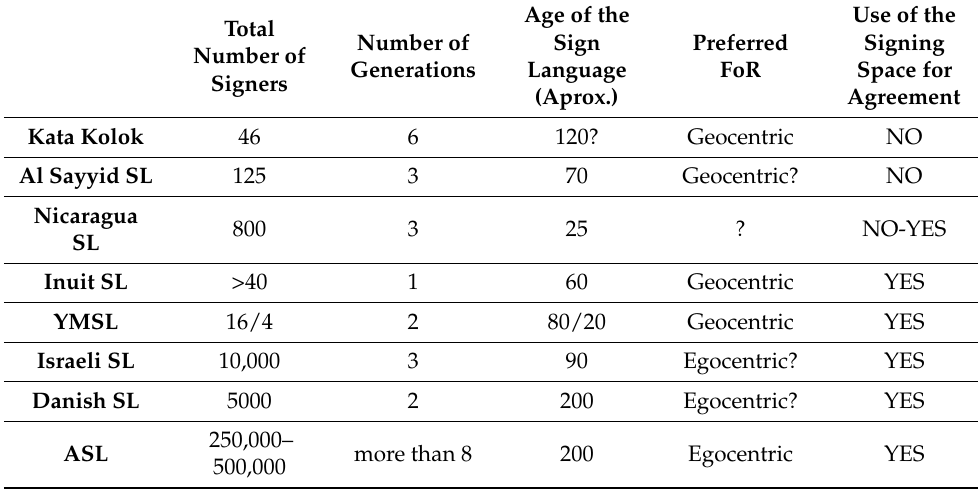
Table 4. Characteristics of various sign languages for cross-cultural comparison; based on de Vos (2012, p. 424), (Meir et al. 2007; Sandler et al. 2005; Aronoff et al. 2005), (Senghas 2003, 2005; Coppola 2020), (Schuit 2012, 2014; Schuit et al. 2011), Engberg-Pedersen (1993), de Beuzeville et al. (2009) and Liddell